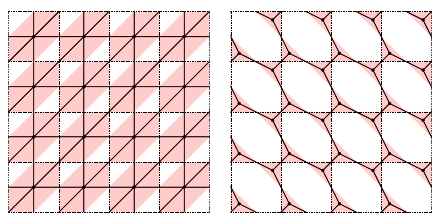
FIG. 7. Matching graphs ( X type) for the subsystem toric code with no triangle operators fixed as stabilizers (left) and all triangle operators fixed as stabilizers